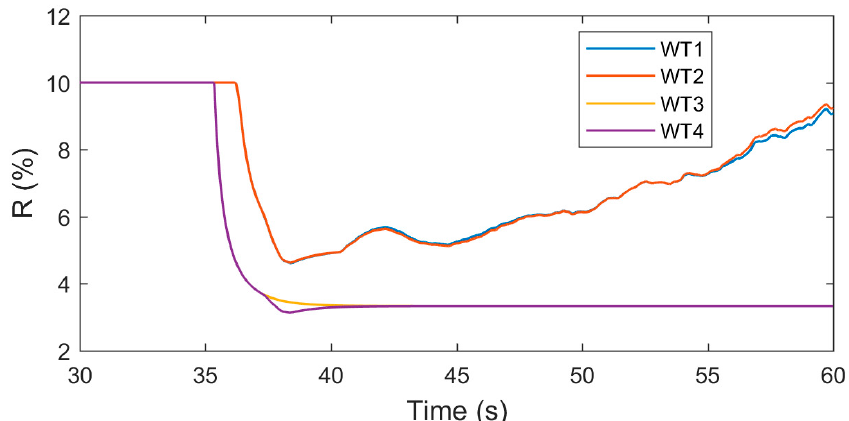
Figure 17. Dynamic droop (wind farm).